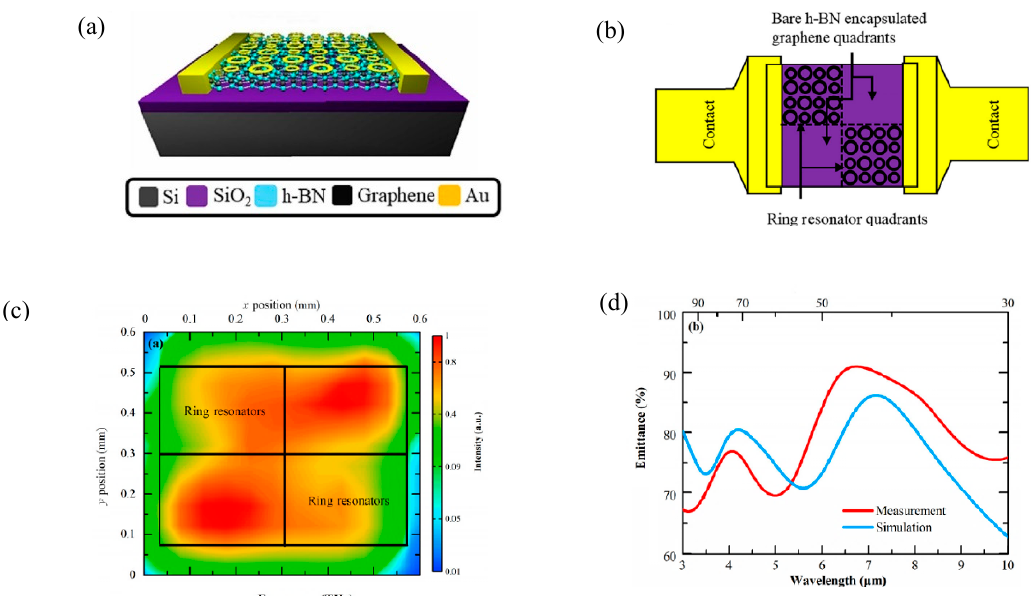
Figure 5. ( a ) The schematic diagram of metamaterial and graphene-based thermal emitter. ( b ) The top view metamaterial graphene-based thermal emitter for the direct comparison of the light-emitting surface patterned with four quadrants (with each 250 µm × 250 µm). The ring resonators consist of 5 / 50 nm thick Cr / Au, patterned on the encapsulated graphene surface, ( c ) the spatial measured thermal radiations from the fabricated device. ( d ) The experimental (red line) and simulated (blue line) emission spectra [104].